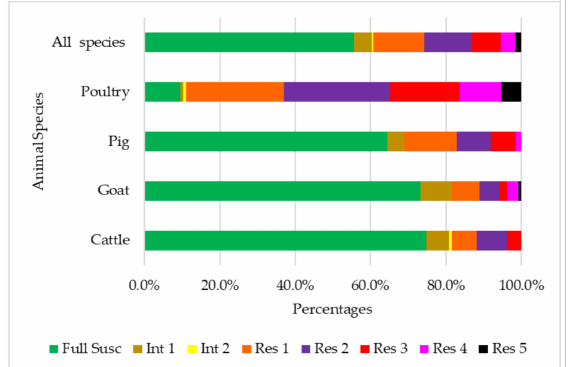
Figure 2. Multidrug-resistant E. coli isolated from the feces of food animals in the East province of Rwanda. The total number of bacterial isolates per animal species was 135. Full Susc: fully susceptible; Int 1: fully susceptible, but intermediate to one antibiotic class; Int 2: fully susceptible, but intermediate to two antibiotic classes; Res 1: resistant to one antibiotic class; Res 2: resistant to two antibiotic classes; Res 3: resistant to three antibiotic classes; Res 4: resistant to four antibiotic classes; Res 5: resistant to five antibiotic